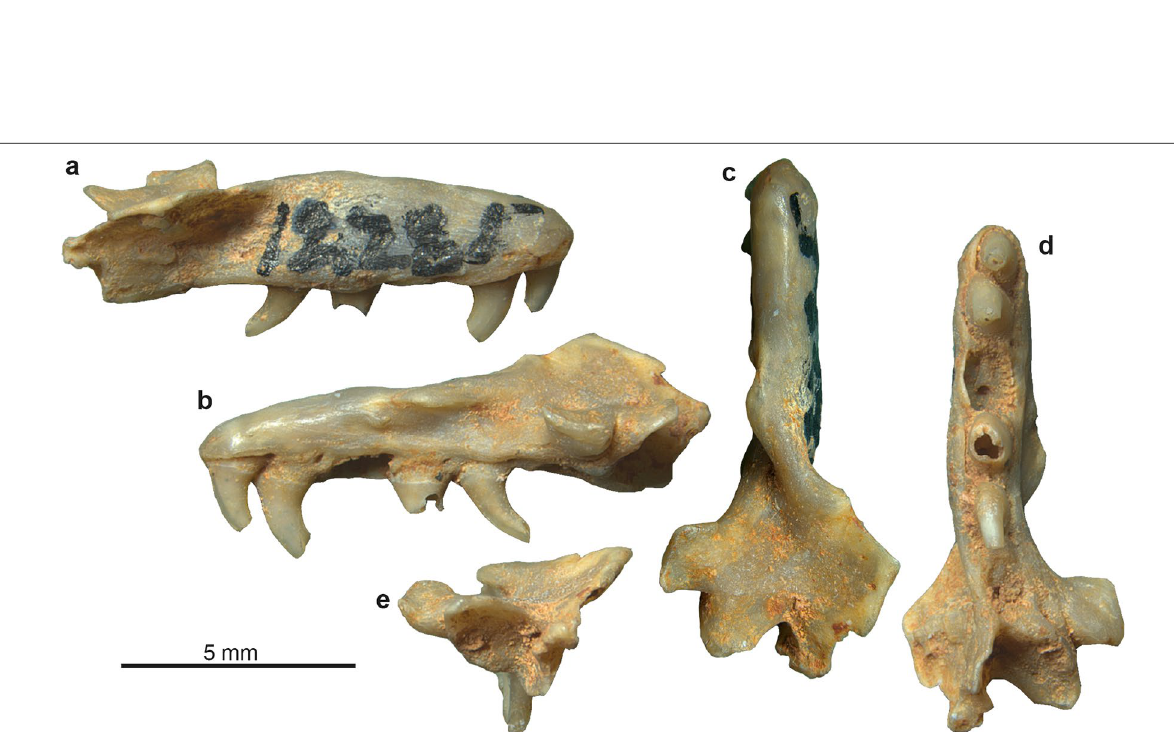
Fig. 105 Constrictores indet. from an imprecisely known locality, near Mouillac, Phosphorites du Quercy: left palatine (YPM-VPPU 12281) in